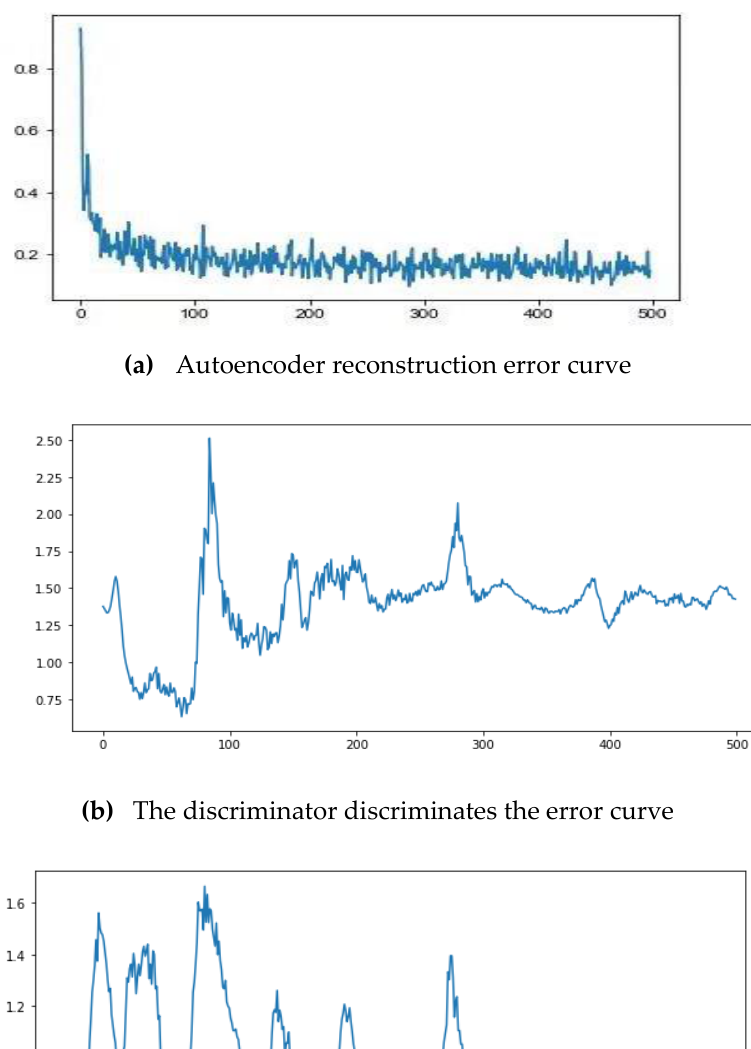
16 of 23 Table 6. Intelligent algorithm comparison. Algorithm